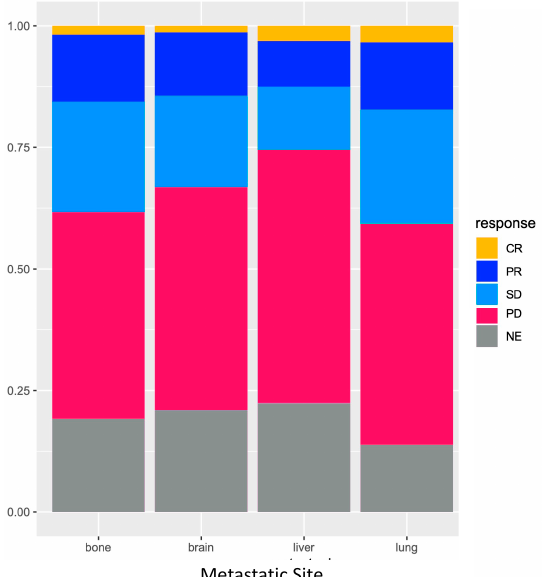
Figure 5. Overall response rate (ORR) according to metastatic location type in the subgroup of patients with only one site of metastasis. Legend: CR—Complete response; PR—Partial response; SD—Stable disease; PD—Progressive disease; NE—Non-evaluable.